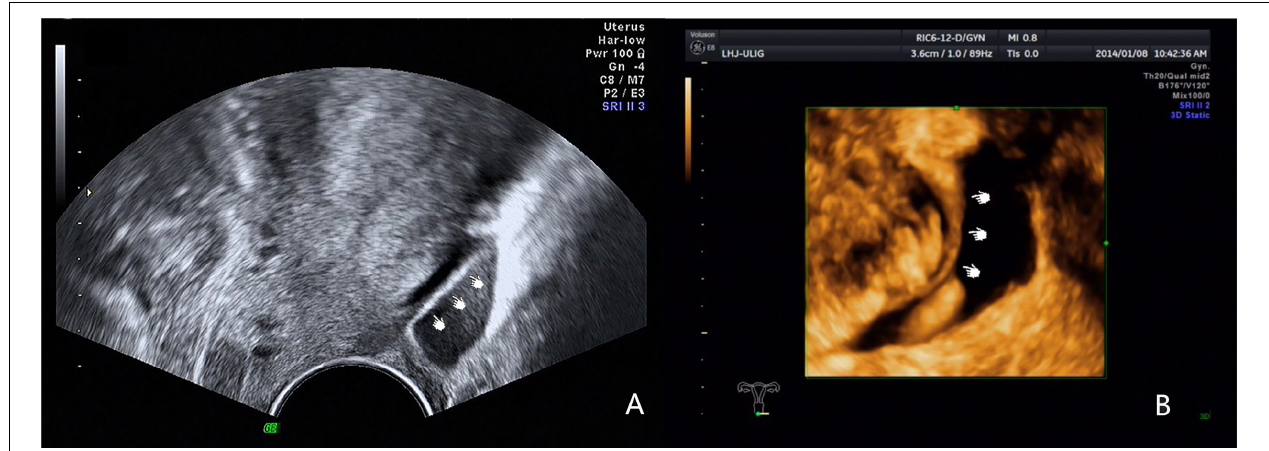
FIGURE 2 | Images showing the normal USL imaged by 2D and 3D ultrasound in patients with fossa effusion. (A) Normal USL imaged by 2D ultrasound. (B) Normal USL imaged by 3D ultrasound.